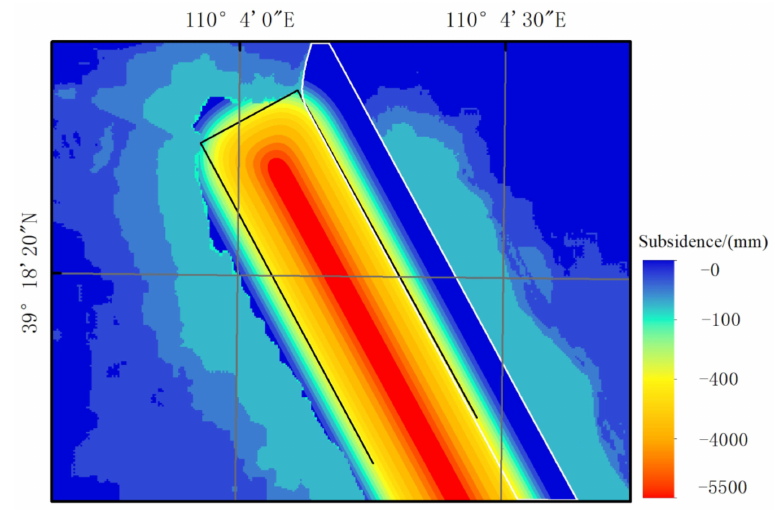
Figure 16. Subsidence results after